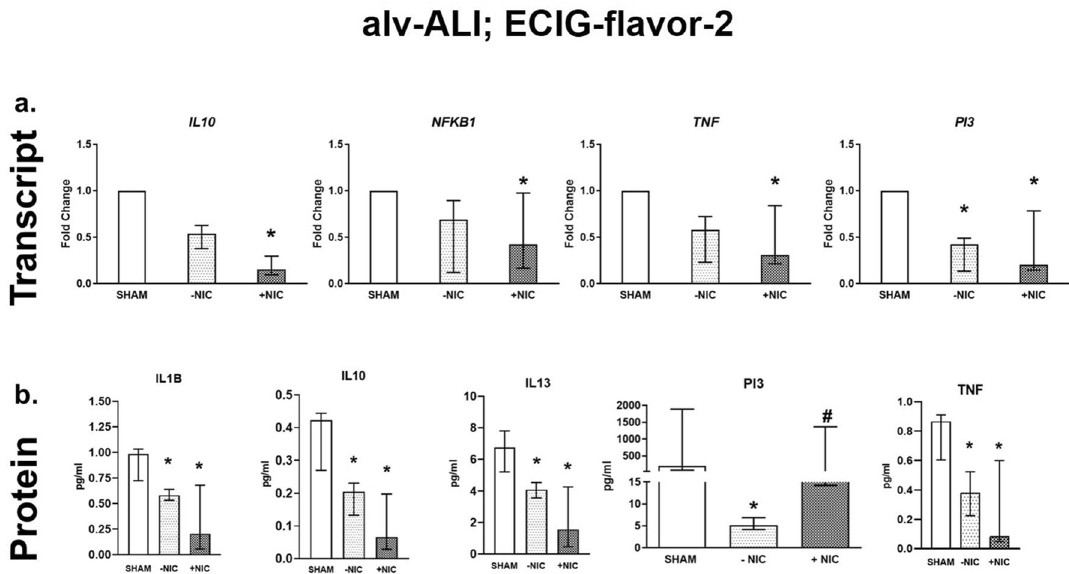
Figure 7. Transcript expression ( a ) and secreted protein levels ( b ) of significantly altered pro-inflammatory, oxidative stress, tissue injury/repair, alarm anti-proteases, and/ or anti-microbial defensin markers in the alveolar mucosa model cultured at air–liquid interface (alv-ALI) following exposure to aerosolized non- nicotinized (−NIC) and nicotinized (+NIC) electronic cigarette liquid flavor 2 (ECIG-flavor-2). Actin beta ( ACTB ) was used as the reference gene. Fold changes for transcript expression were calculated relative to the corresponding sham *: significantly different from sham; #: significantly different from −NIC ( p < 0.05, Friedman followed by Wilcoxon test). IL: interleukin, NFKB1: nuclear factor kappa B subunit 1, PI3 : peptidase inhibitor 3, TNF : tumor necrosis factor.